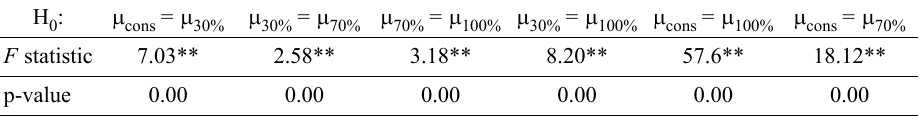
Table 9. Results of variance hypothesis testing across 4 fund categories H 0